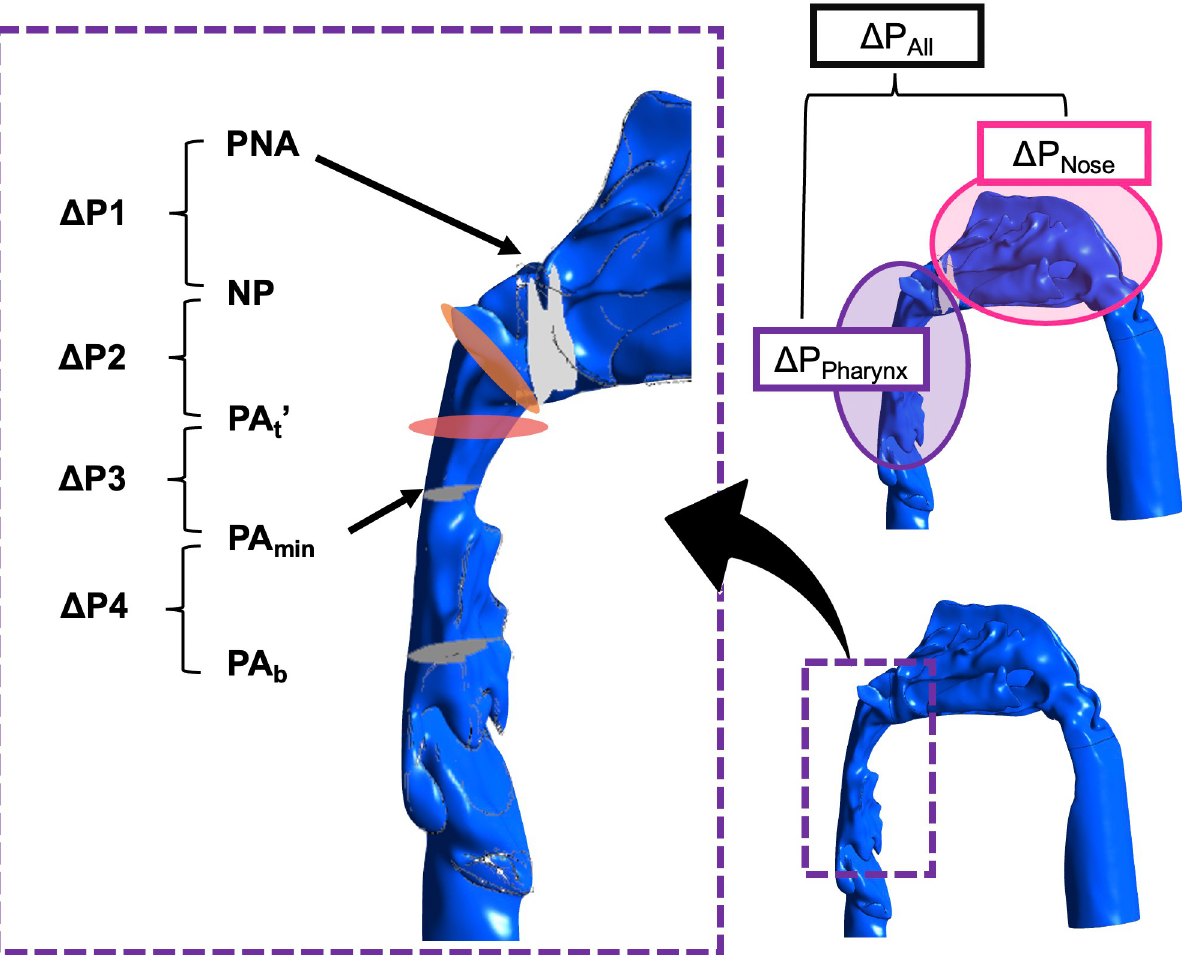
Fig 6. Segments in which the pressure drop was evaluated. Lateral view of the nasopharynx and oropharynx. Pressure drop was defined by the pressure at any two cross-sectional